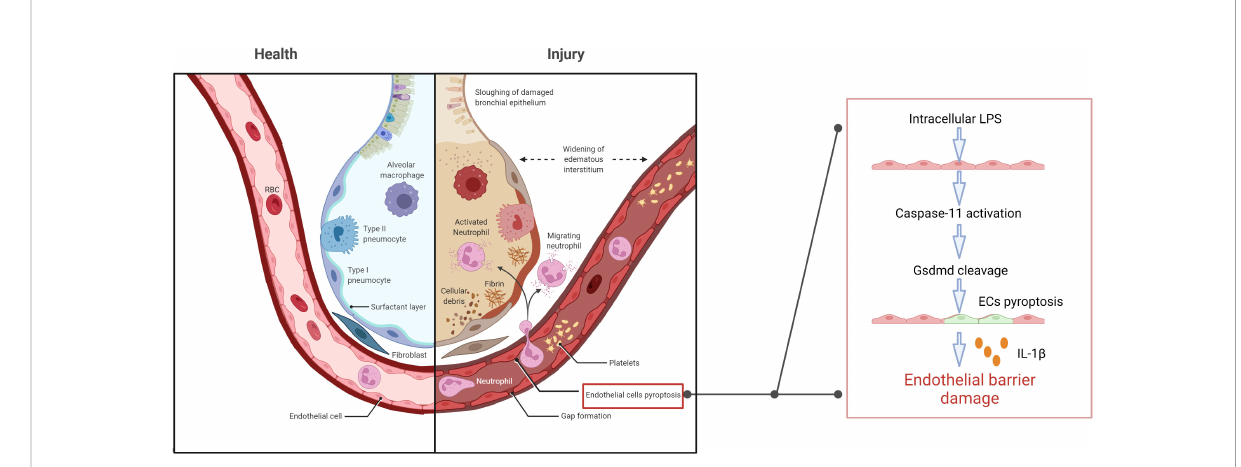
FIGURE 1 Extracellular LPS enters the endothelial cytoplasm through the cell membrane, and then triggers caspase-11-dependent endothelial cell pyroptosis and damages the pulmonary endothelial barrier, resulting in pulmonary edema, proin fl ammatory cytokine release, fl uid and protein leakage, and massive in fl ux of